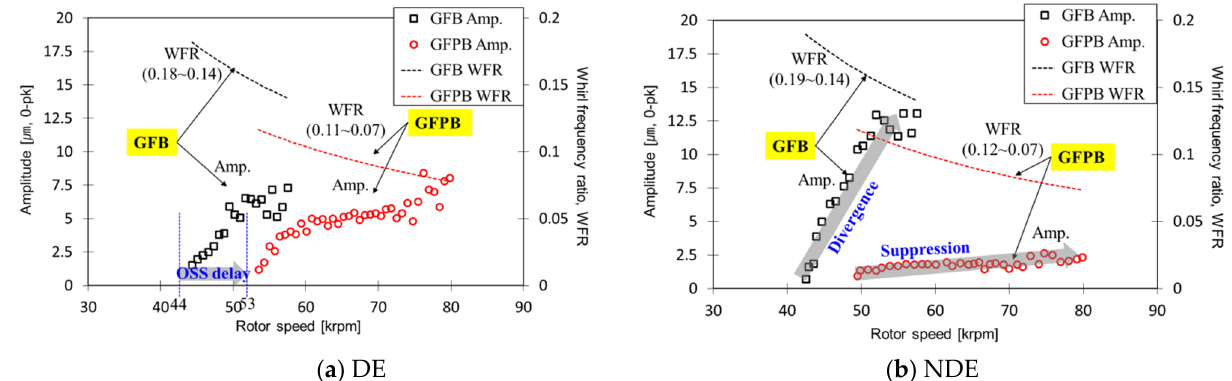
Figure 11. Filtered sub-synchronous vertical motions for GFB and GFPB: measured at ( a ) DE and ( b ) NDE sides.